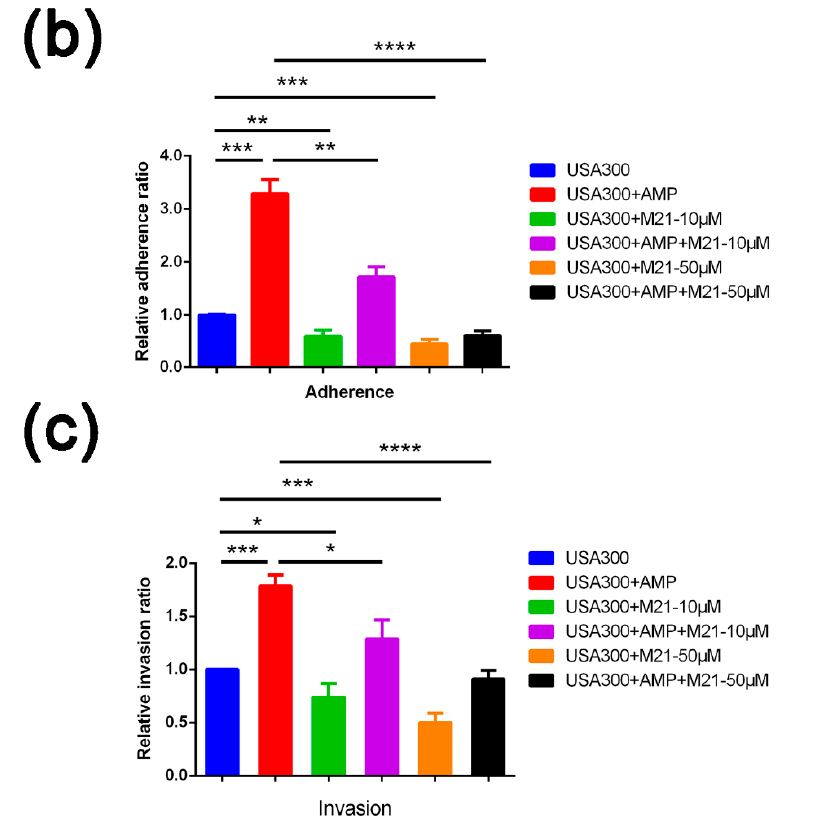
Figure 1. M21 reduced the S. aureus virulence induced by antibiotics. ( a ) The interaction of compound M21 and ampicillin on eight different promoters. Paper discs with 5 µ L of 10 mM ampicillin were placed in the middle; the other two are paper discs with 5 µ L of compound M21 (50 mM). The distance between the paper discs is shown in the figure. ( b , c ) Effect of compound M21 on the ampicillin-enhanced adherence ( b ) and invasion ( c ) of USA300 in A549 cells. Relative invasion and relative adherence assays were performed in triplicate and experiments were repeated twice. Using non-parametric tests, the treated groups were compared with the control group. Data represent mean values ± SEM (* p < 0.05; ** p < 0.01; *** p < 0.001; **** p <